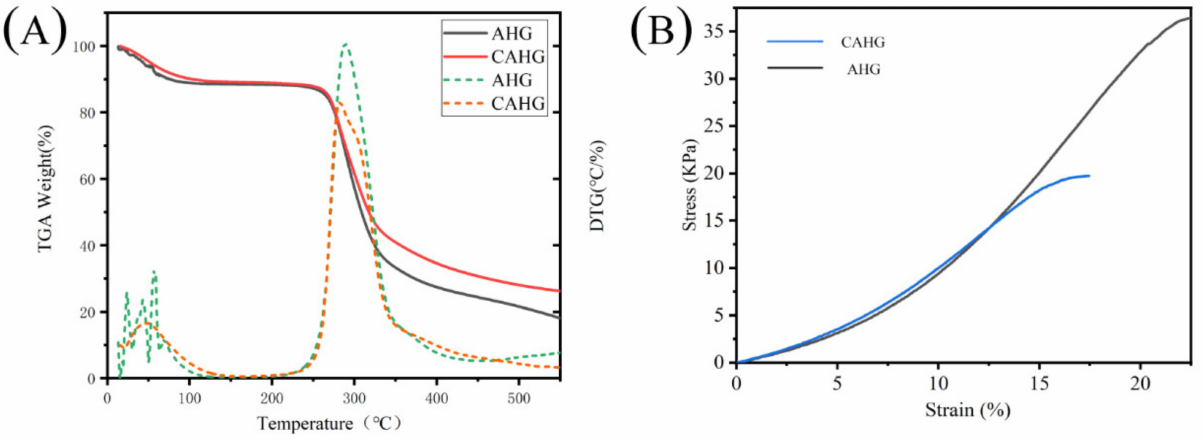
Figure 4. TGA (solid line) and DTG (dotted line) of AHG and CAHG ( A ); stress-strain curves of AHG and CAHG ( B